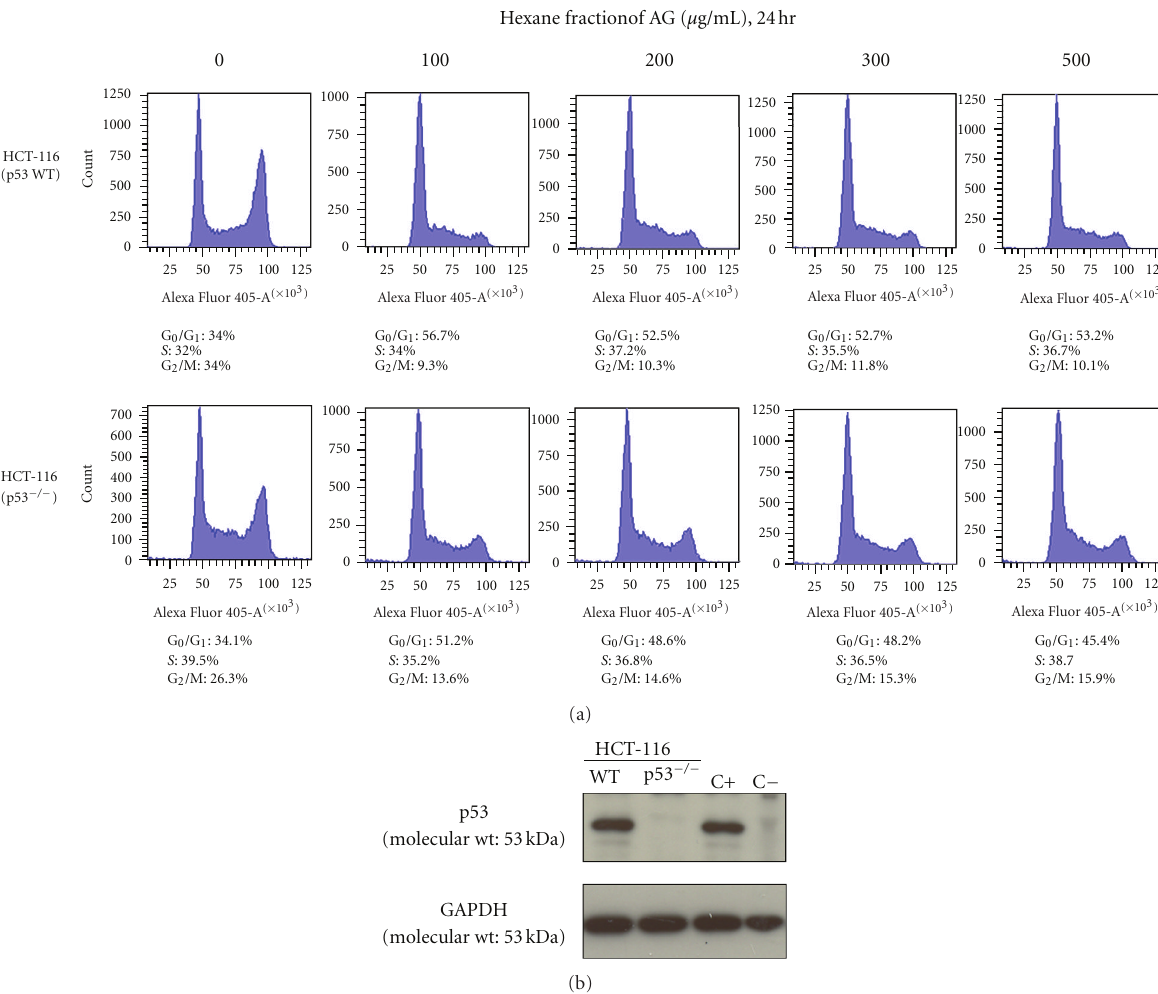
Figure 4: The HAG induces a G 1 checkpoint in colon cancer cells in both p53 + / + and p53 − / − colon cancer cells. (a) HCT-116 WT and p53 − / − cells were exposed to HAG in RPMI-1640 + 1% NBCS for 24 hr at indicated doses and harvested for cell cycle assay with DAPI stain. Representative percentage of cells in G 1 , S, and G 2 /M-phases are indicated for each treatment. A minimum of 20,000 events was counted by flow cytometry from each treatment. (b) Confirmation of p53 protein status of the HCT-116 cells. Cell lysates were analyzed by western blot analysis. C+ indicates the positive control for p53, which is an archived HCT-116 cell lysate with wild-type p53. C − indicates the negative control for p53, which is an archived HCT-116 p53 − / − cell lysate with p53